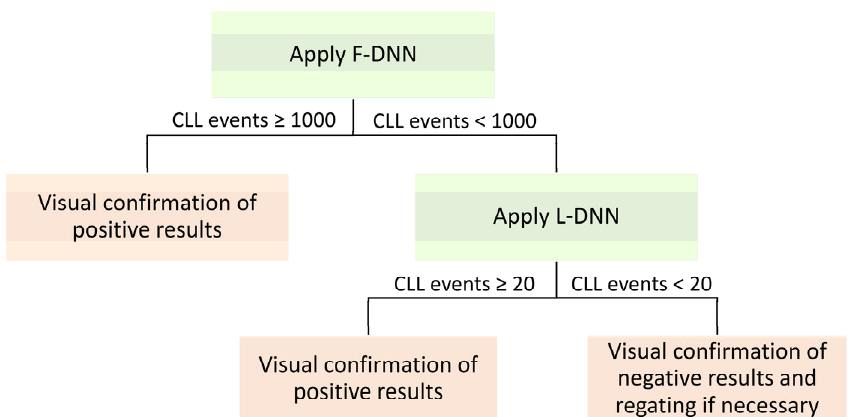
Figure 3. Proposed approach to apply F-DNN on all cases followed by L-DNN on cases with < 1000 abnormal events.